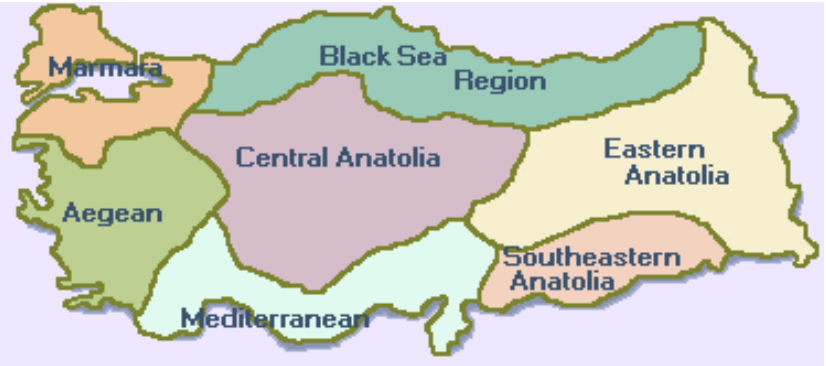
Figure 1. The seven geographical at-large regions of Turkey. The study was conducted in the city of Istanbul (Marmara region).